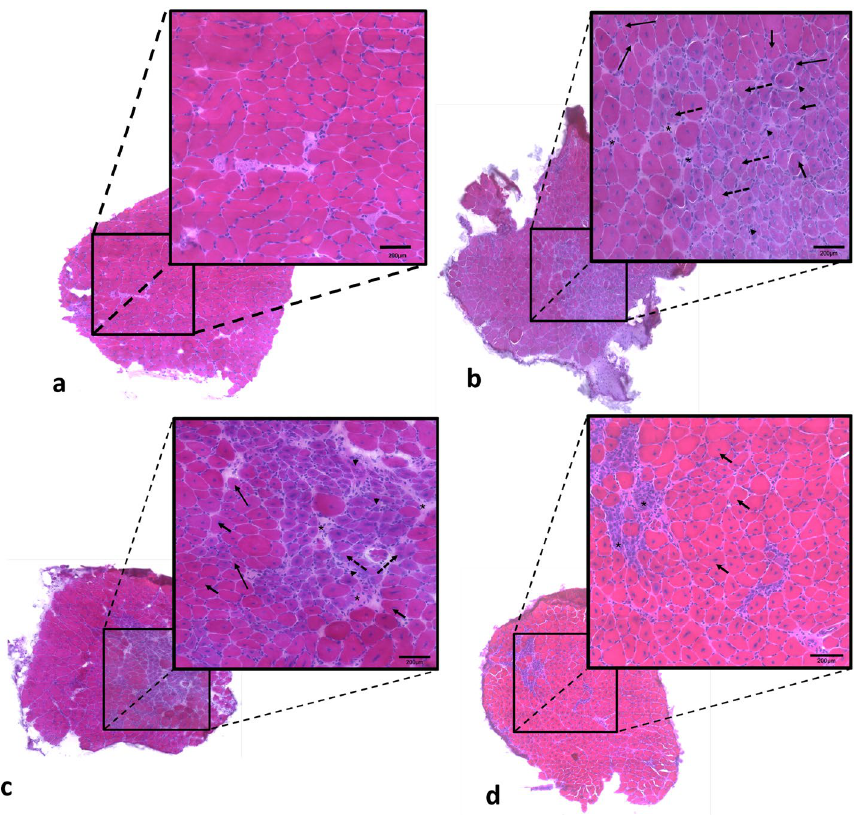
Figure 2. Photomicrographs of soleus muscle stained with hematoxylin and eosin (HE). A wt SED sample, with polyhedral fibers with peripheral nuclei; B mdx SED sample, showing variations in fiber size, increased of connective tissue (*), nuclear centralization (thick arrow), splitting (thin arrow), necrosis (arrowhead), cytoplasmic rarefaction (dotted arrow), and basophilic cell (purples cell); C mdx TR 3 sample, showing variation in fiber size, increased of connective tissue (*), nuclear centralization (thick arrow), cytoplasmic rarefaction (dotted arrow), and splitting (thin arrow); D mdx TR 21 sample, showing less variation in fiber size, in connective tissue (*), and nuclear centralization (thick arrow). Bars: 200 μm. Abbreviations: wild-type Sedentary group ( wt SED); mdx Sedentary group ( mdx SED); wild-type Training group for 3 days ( wt TR 3 ); mdx Training group for 3 days ( mdx TR 3 ); wild-type Training group for 21 days ( wt TR 21 ); and mdx Training group for 21 days ( mdx TR 21 ).